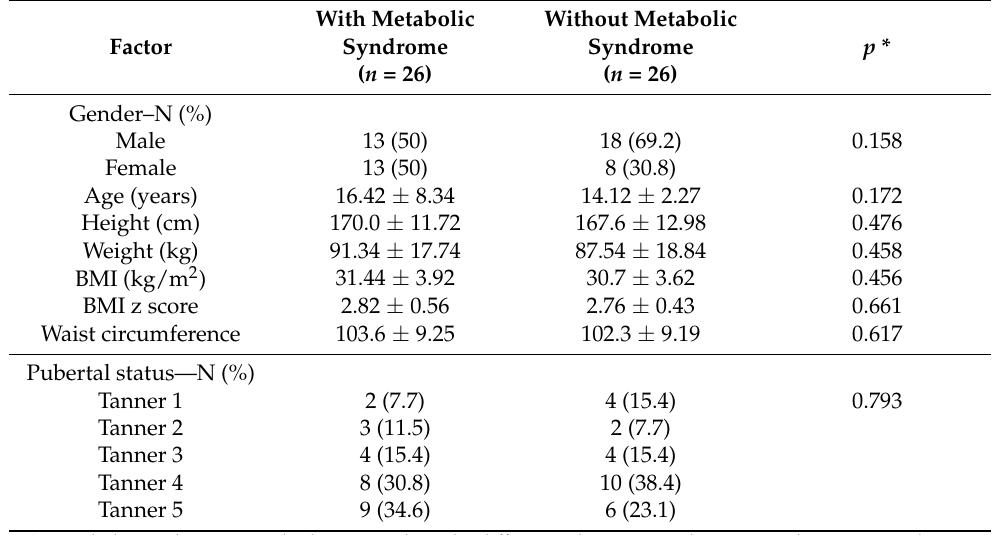
Table 1. Anthropometric characteristics of the research